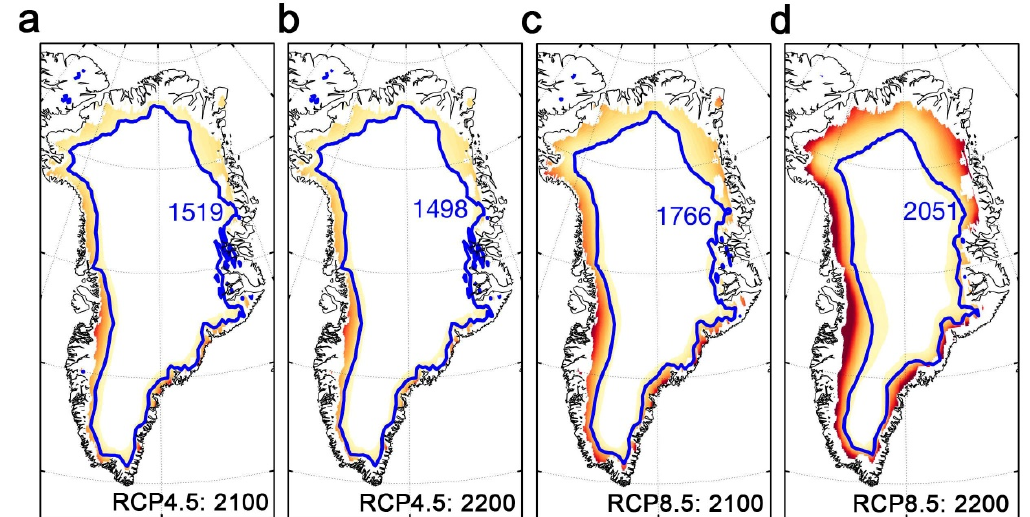
Figure 10. Multi-model mean runoff estimated by two DD methods in 2100 ( a , c ) and 2200 ( b , d ) under RCP4.5, RCP8.5, and their extensions. Blue curves represent equilibrium line, and numbers in blue are ELA (m).